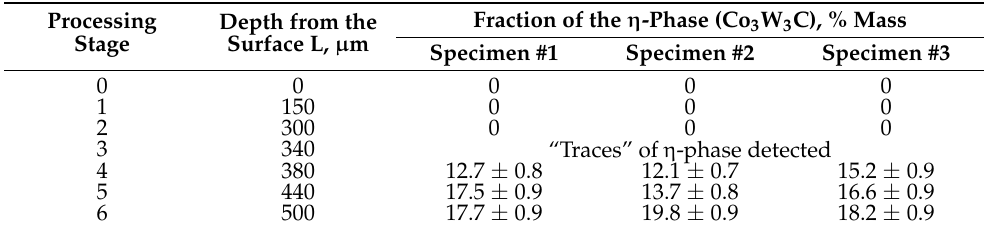
Table A2. The mass fraction of the η -phase in the WC-10Co hard alloy specimens obtained by SPS subject to the removed layer thickness.